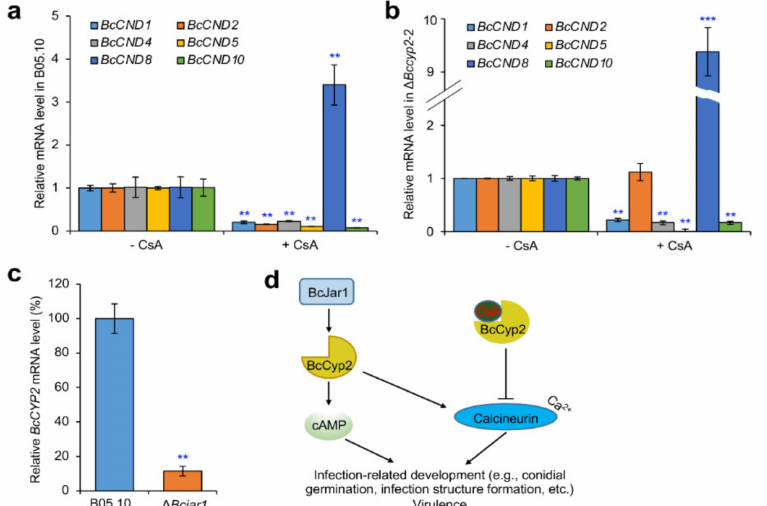
Figure 7. BcCyp2 regulates expression of calcineurin-dependent (CND) genes and is regulated by H3K4 demethylase BcJar1. ( a , b ) Relative transcriptional level of CND genes in the WT B05.10 ( a ) and mutant ∆ Bccyp2 -2 ( b ) strains. Conidia of the two strains were grown in liquid YG medium for 60 h and then moved to the same medium without the nitrogen source (YG-N) and incubated for 4 h, the mycelia of the tested strains were further incubated with YG-N medium containing 10 µ g/mL CsA for 3 h and then collected for RNA extraction. The mRNA levels of Ca 2+ /calmodulin signaling genes were determined by quantitative reverse transcription PCR (qRT-PCR). ( c ) Loss of BcJAR1 [36] downregulates BcCYP2 expression level. Mycelial plugs of B05.10 or ∆ Bcjar1 strain were induced for IC formation. At 36 hpi (during IC formation), mycelia of the tested strains were then collected and subjected to RNA extraction. The mRNA levels of BcCYP2 were determined by qRT-PCR. ( d ) Proposed models describing BcCyp2 regulation of fungal infection-related development and virulence as well as CsA-mediated functional blocking. Data represent means ± SD from three independent experiments. **, ***: significance at p < 0.01 and 0.001,